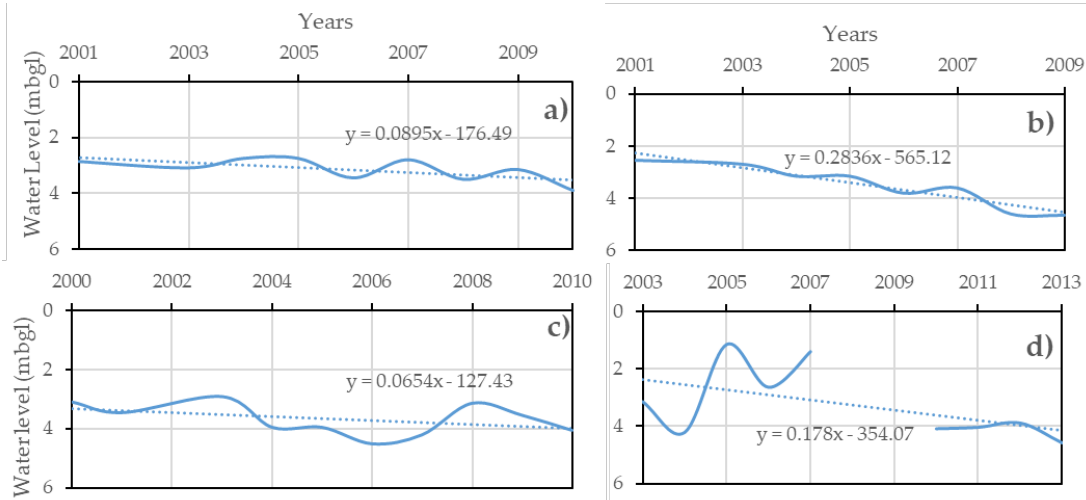
Figure 10. Water level in meters below ground level (mbgl) for the month of May (driest month) in different observation wells around the study area: ( a ) STW1, ( b ) STW2, ( c ) STW3, and ( d ) DTW1.